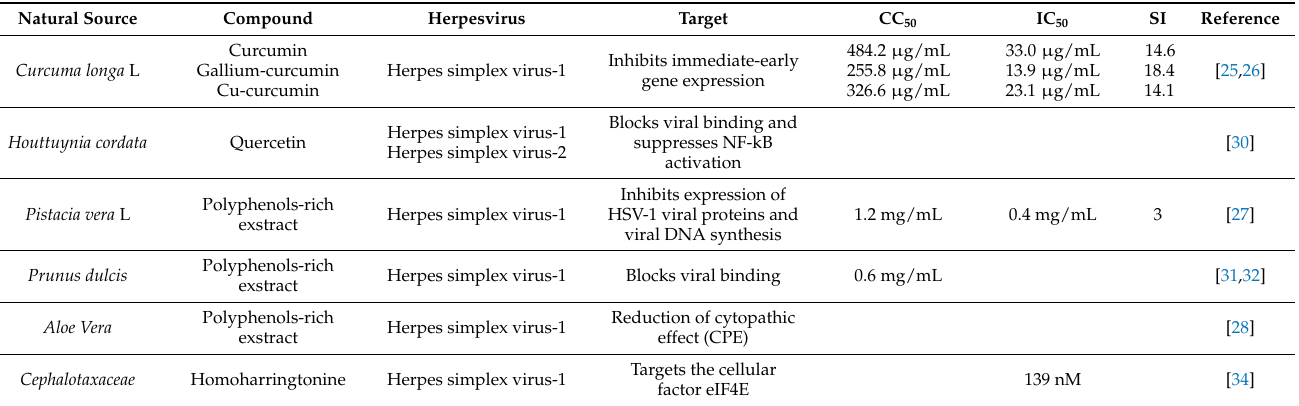
Table 2. Natural compounds and their antiviral targets against